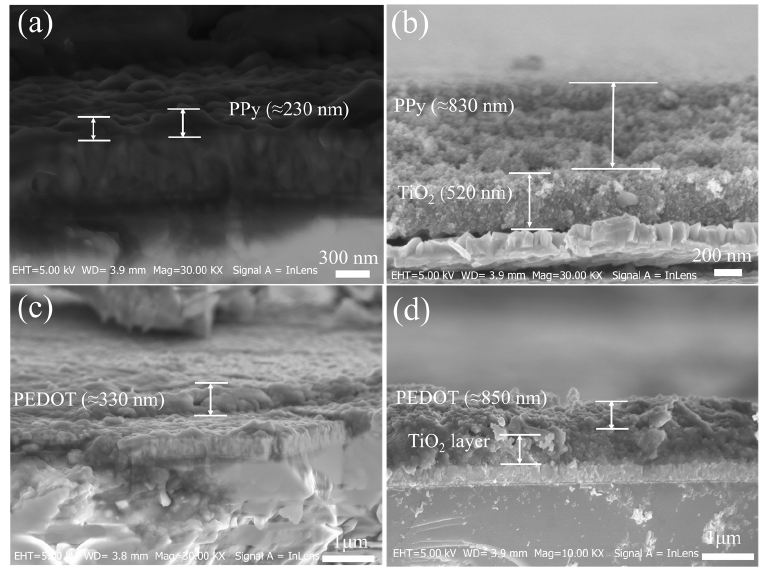
Figure 3. SEM images of cross-section of ( a ) PPy film (230 nm), ( b ) PPy@TiO 2 film, ( c ) PEDOT film (330 nm), and ( d ) PEDOT@TiO 2 film.